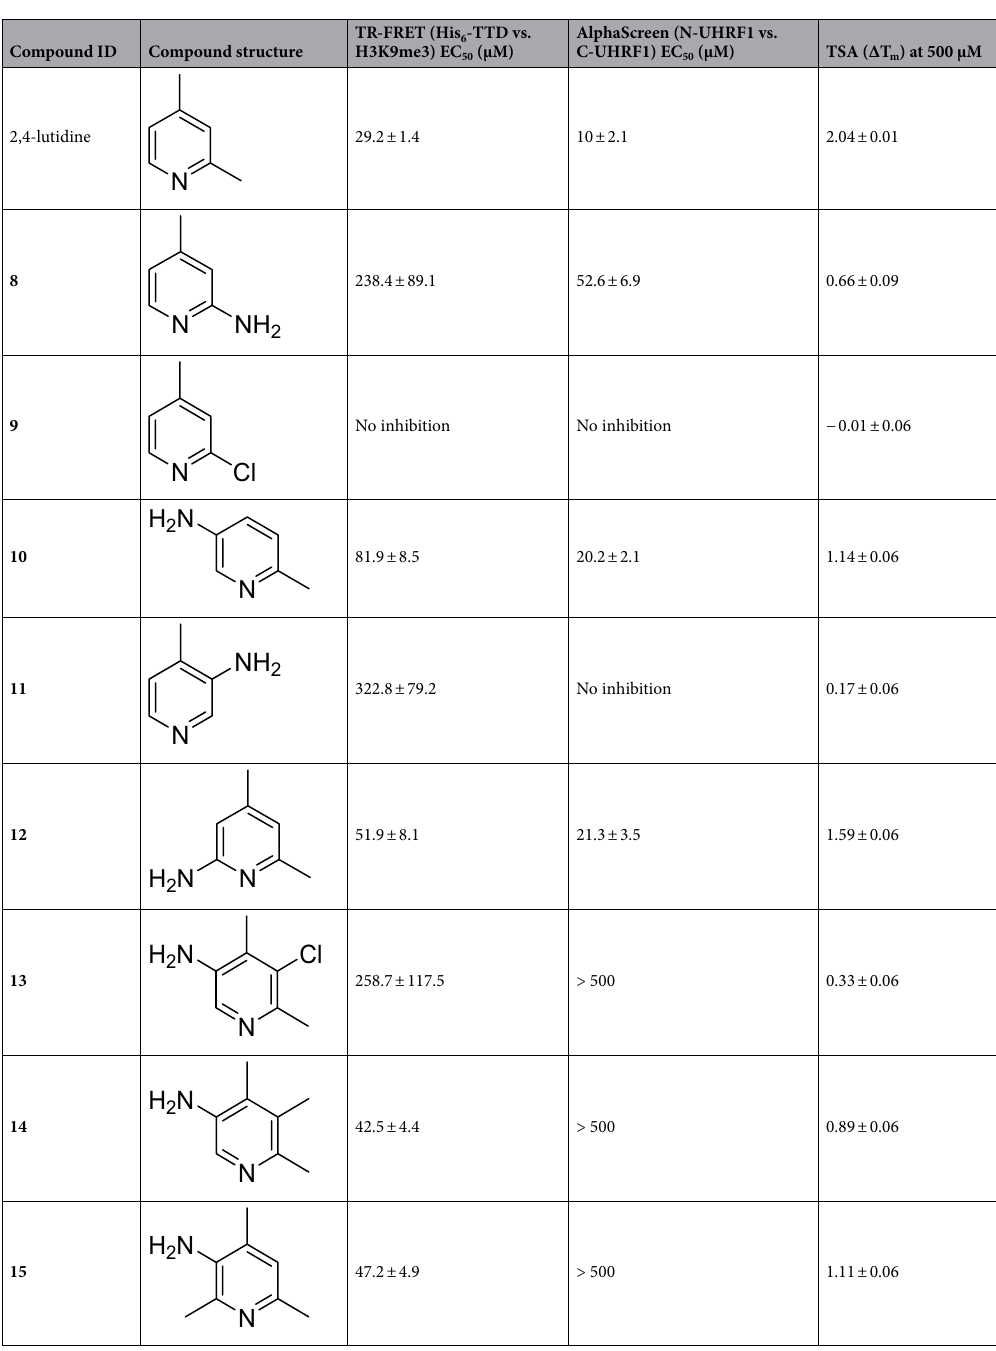
Table 2. The SAR of F1957-0088 homologs with single pyridine ring The EC 50 of TR-FRET and AlphaScreen assays are reported as EC 50 ± S.E.M. and the ΔT m of TSA assay is reported as mean ± S.D. n=3 for AlphaScreen, TR-FRET, and TSA. Note that “no inhibition” means little to no change in assay readout even at the highest compound concentration tested (1mM) while “>500” means there is assay signal reduction/inhibition at highest concentrations yet the EC 50 determined by curve fitting is above 500